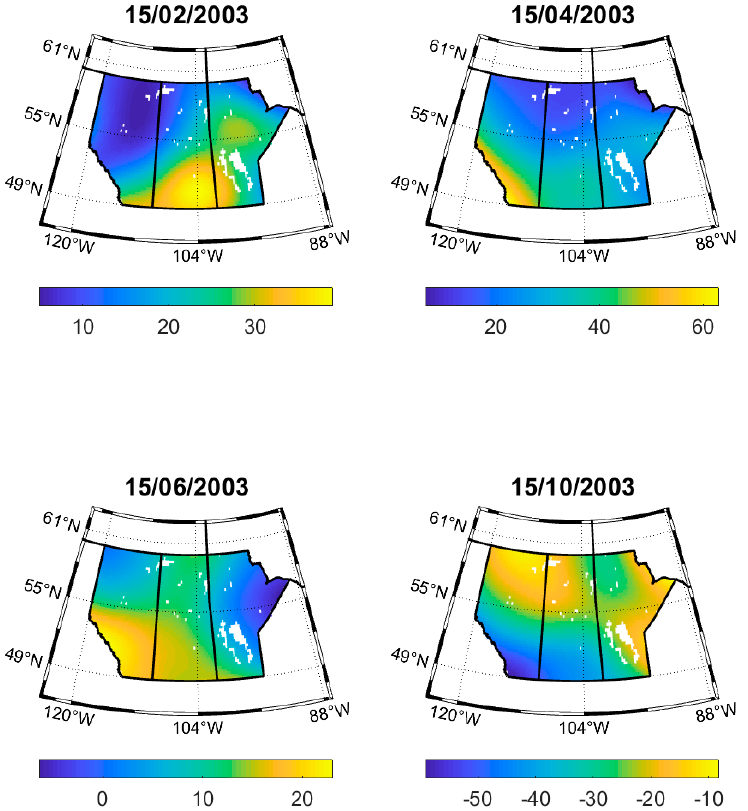
Figure 7. GRACE terrestrial water storage anomalies (TWSA) after downscaling on the 15th day of each selected month with separate colour bar ranges [mm].